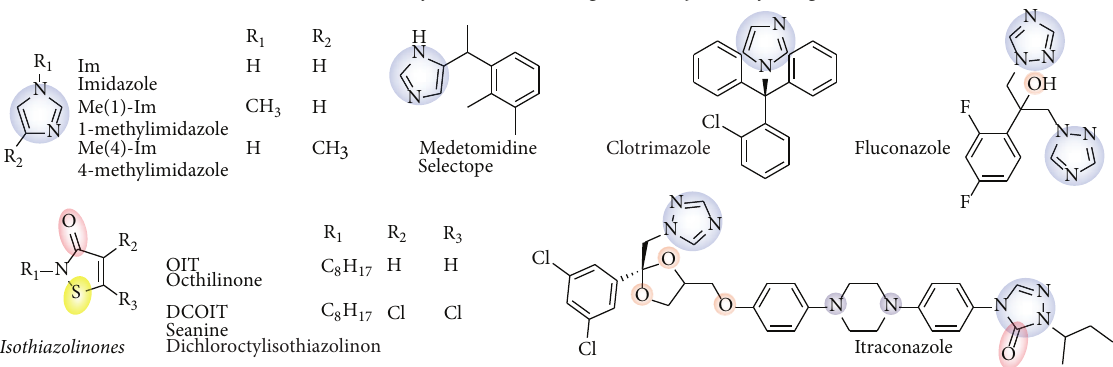
trigger the release from the microcapsule shell as a function of contact with water or moisture (see Scheme 2).